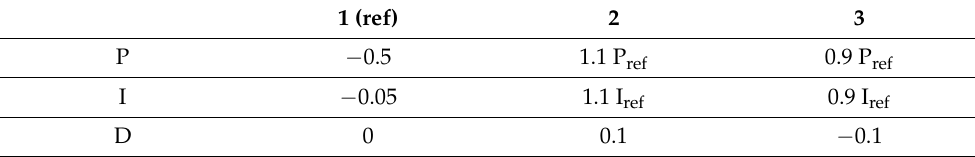
Table 5. Sensitivity analysis on the parameters of the PID controller.